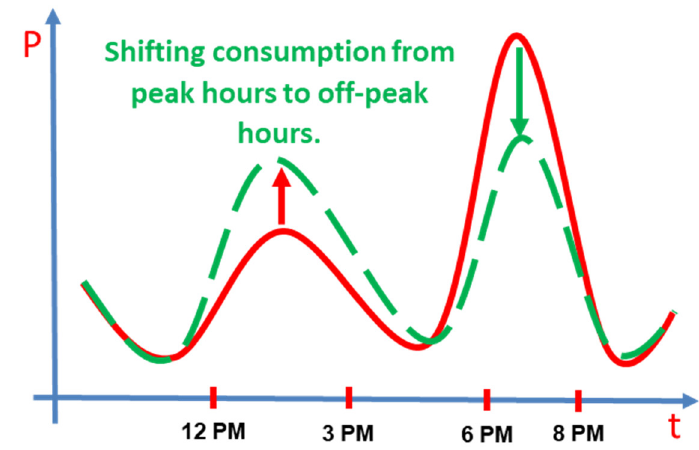
Figure 9. Load shifting using demand-side energy flexibility [51].